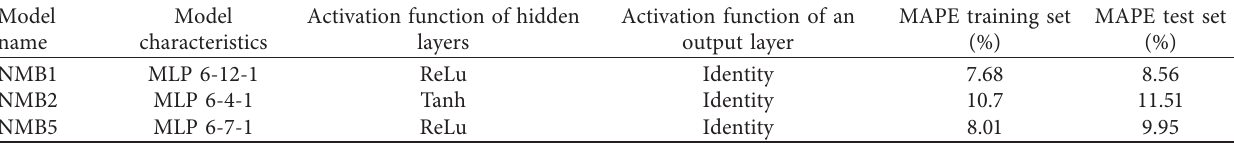
Table 5: Artificial neural network models for estimating concrete consumption (StandardScaler).